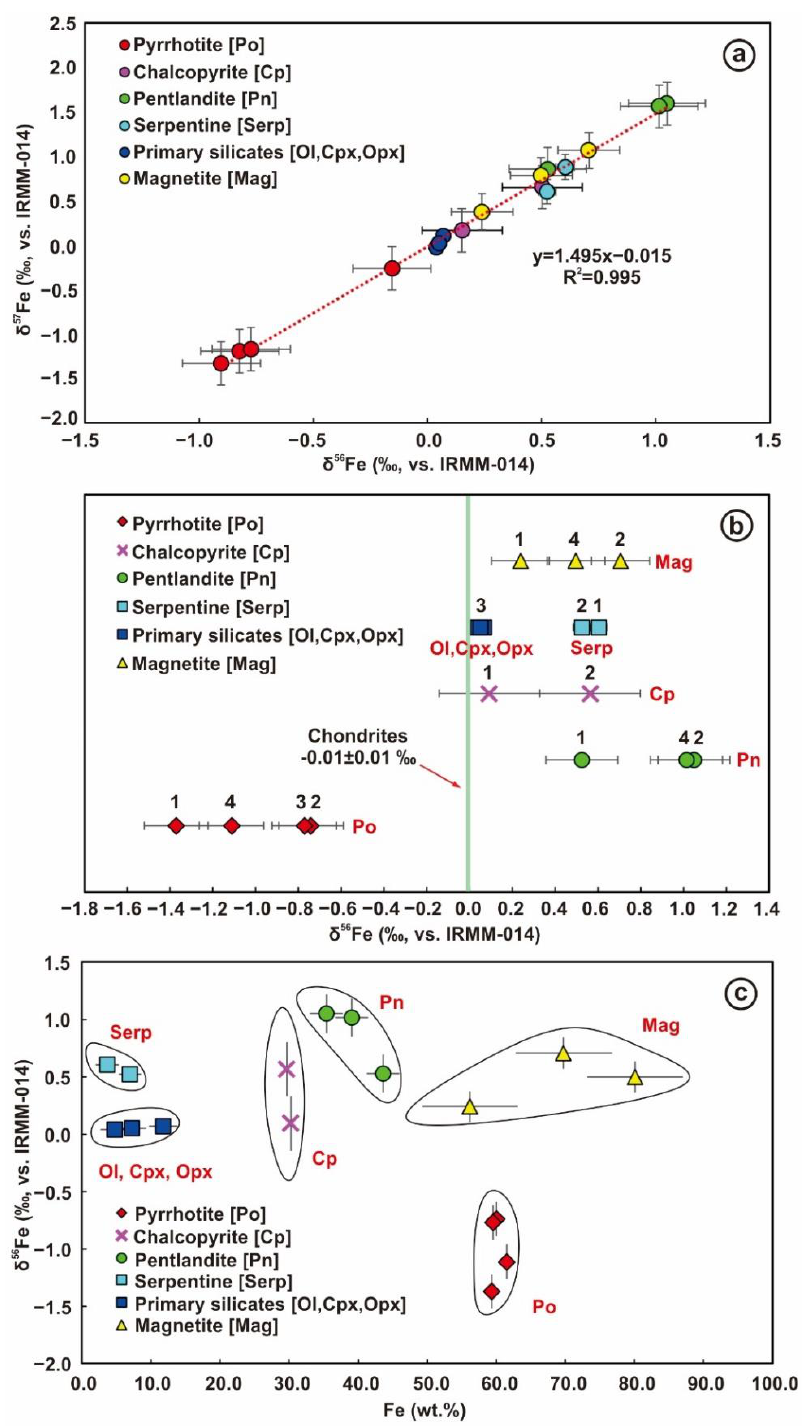
Figure 5. ( a ) Iron isotope compositions of the mineral separates from the Jinchuan sulfide ore samples plot along a mass-dependent fractionation line, confirming high quality of the data. Error bars represent ±1sd. ( b ) Iron isotope compositions of the mineral separates in ore samples from the Jinchuan deposit, compared with the carbonaceous chondrite data (δ 56 Fe = −0.01 ± 0.01‰ ( n = 10)) [2–6]. Numerals 1, 2, 3, and 4 represent samples JC-1, JC-2, JC-3, and JC-4. ( c ) The relationship between δ 56 Fe values and Fe content (wt.%) for varying minerals from the Jinchuan ore deposit. Mineral abbreviations: Ol = olivine; Srp = serpentine; Cpx = clinopyroxene; Opx = orthopyroxene; Mag = magnetite; Po = pyrrhotite; Cp = chalcopyrite; Pn = pentlandite.